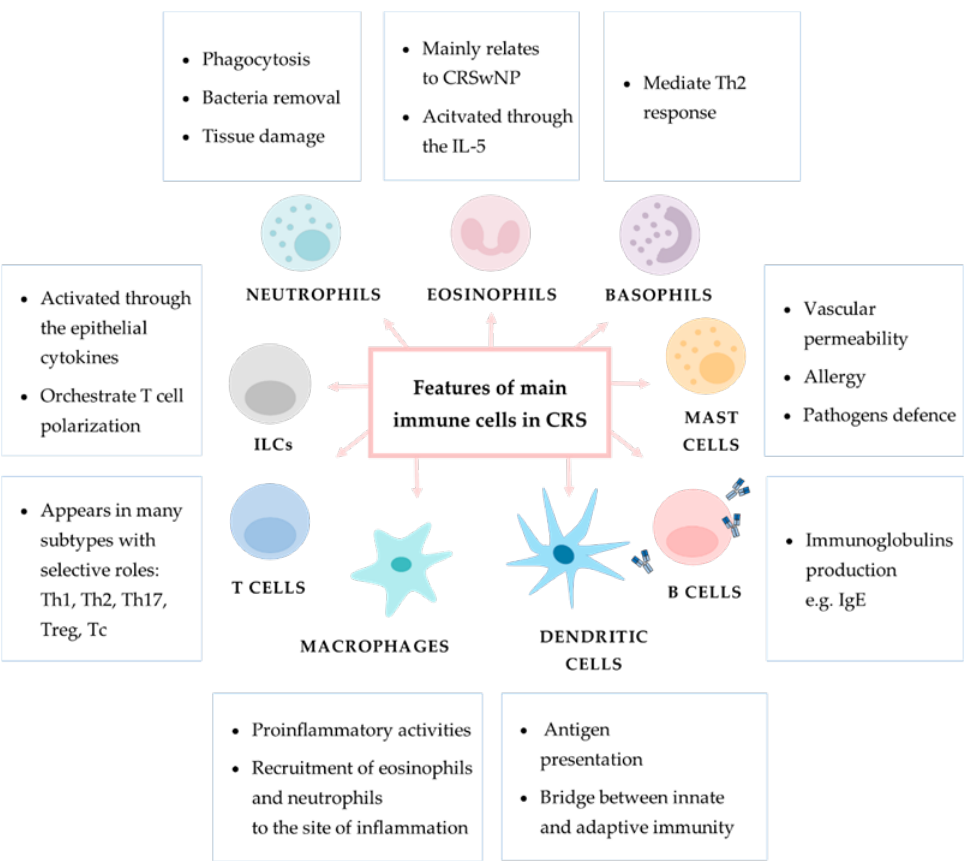
Figure 5. General information regarding the role of main immune cells in chronic inflammation in CRS. In the boxes provided are descriptions of particular immune cells ’ main functions.